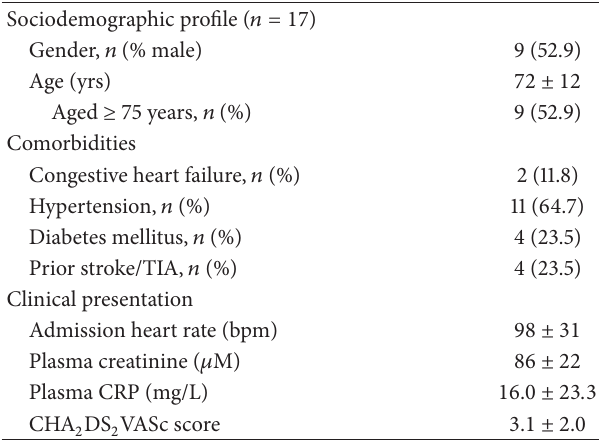
Table 1: Clinical profile of the study cohort.